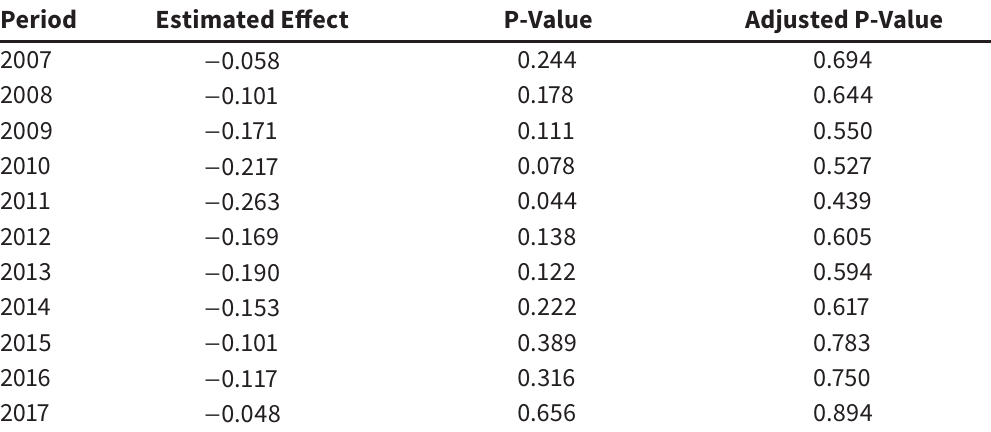
Treatment Effects and Significance for Log Teen Employment/Population Ratio in Puerto Rico (Limited Donor Pool)